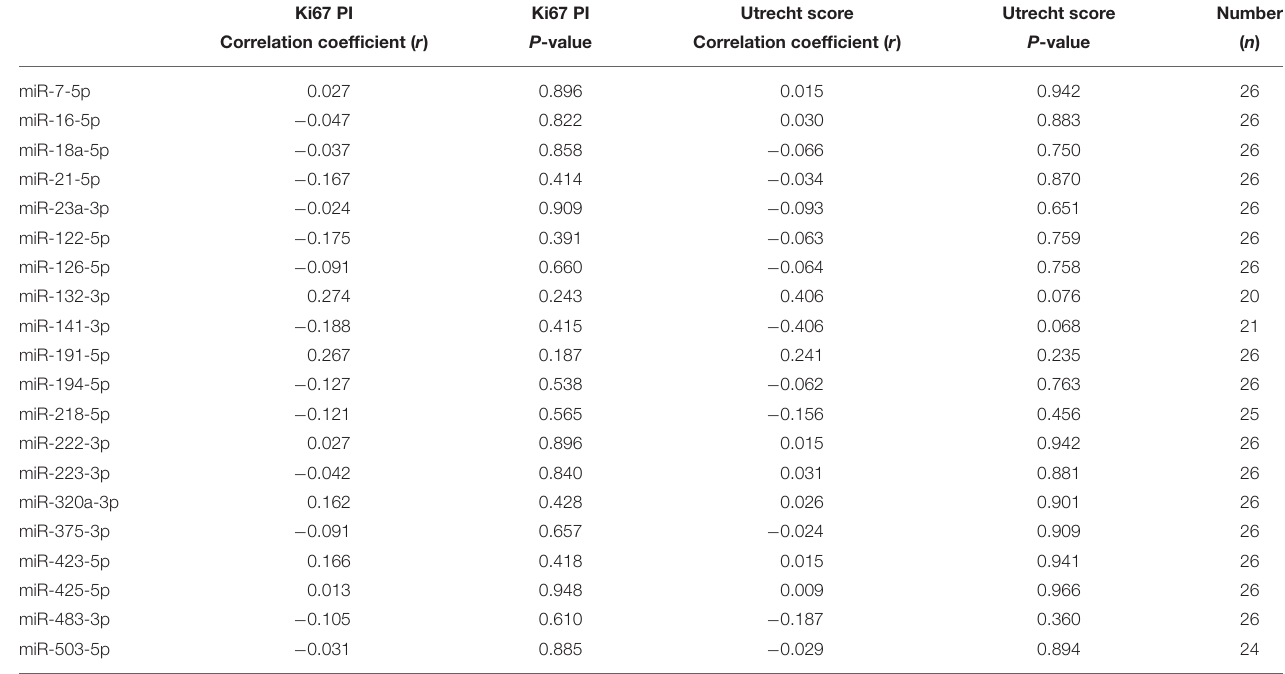
TABLE 2 | Correlation of circulating miRNA expression with Ki67 proliferation index (PI) and Utrecht score in dogs with